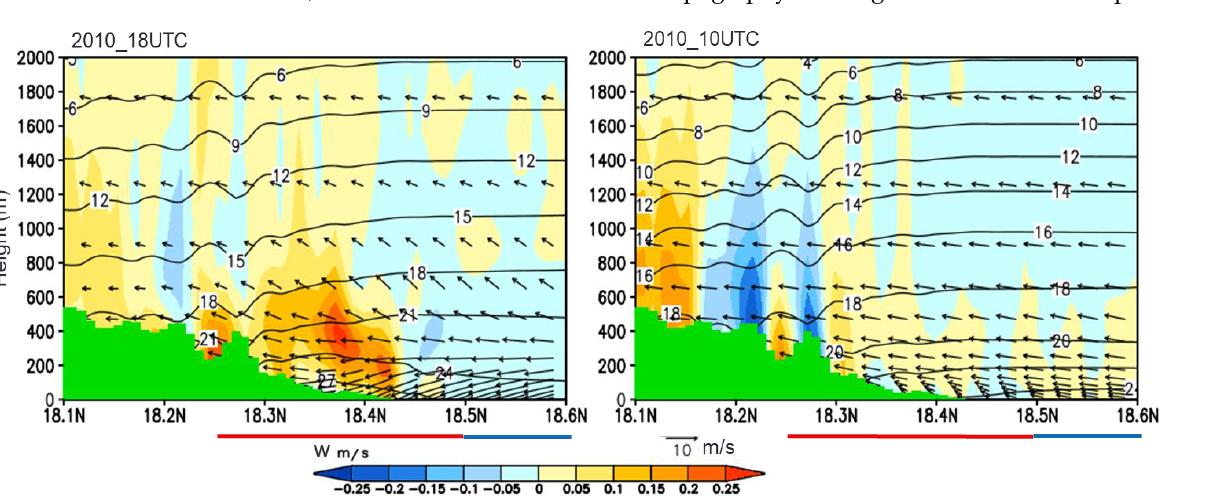
Figure 8. PDF of mean daily maximum temperature ( left ) and mean peak heat index ( right ) for the densely packed region of SJMA.